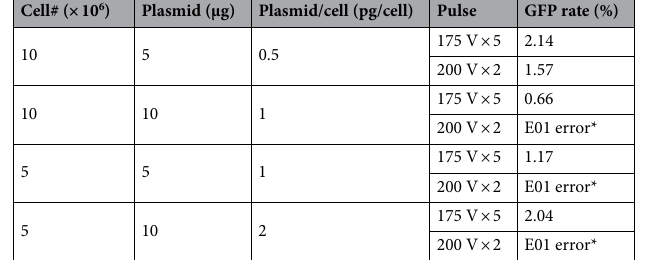
Table 4. Fining of pulse condition using the Ingenio buffer and NEPA21 electroporator. *: Overcurrent error.